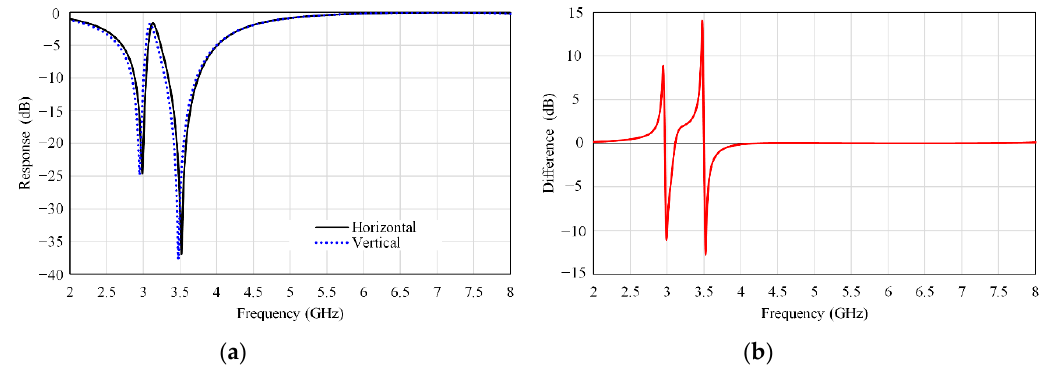
Figure 11. Code: 1010000000. ( a ) Frequency responses under excitation with vertical and horizontal polarizations. ( b ) The amplitude difference in dBs between the two responses.